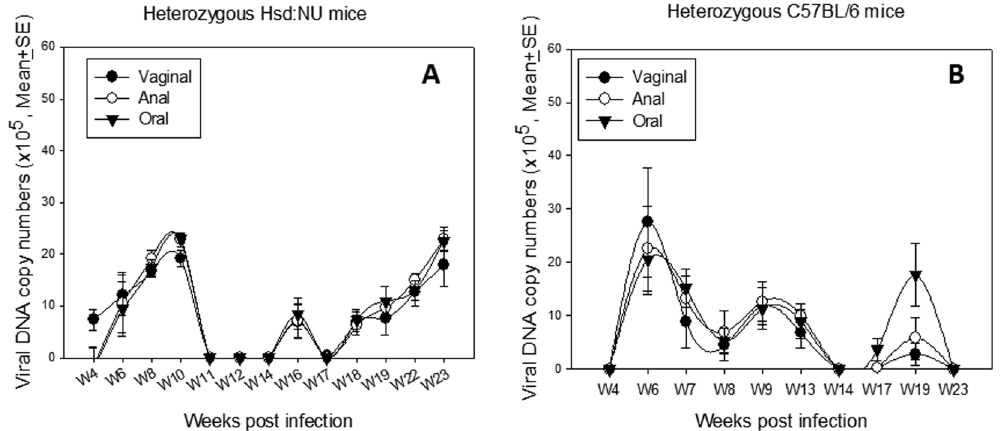
Figure 7. Immunocompetent heterozygous Hsd: NU and C57BL/6 mice maintain vaginal, anal, and oral mucosal infections over time. Infections in additional immunocompetent heterozygous strains of mice (Hsd: NU and B6) were also tracked over time in an experiment that is still ongoing. Heterozygous Hsd: NU mice showed persistent infection over the time courses ( A ) similar as shown in herterozygous NU/J mice (Fig. 3A). Hsd: NU heterozygotes have maintained infections up to the 23 week time point ( A ). B6 heterozygous animals ( B ) were permissive to MmuPV1 infection but showed no detectible infections at any of the sites after week 23 time